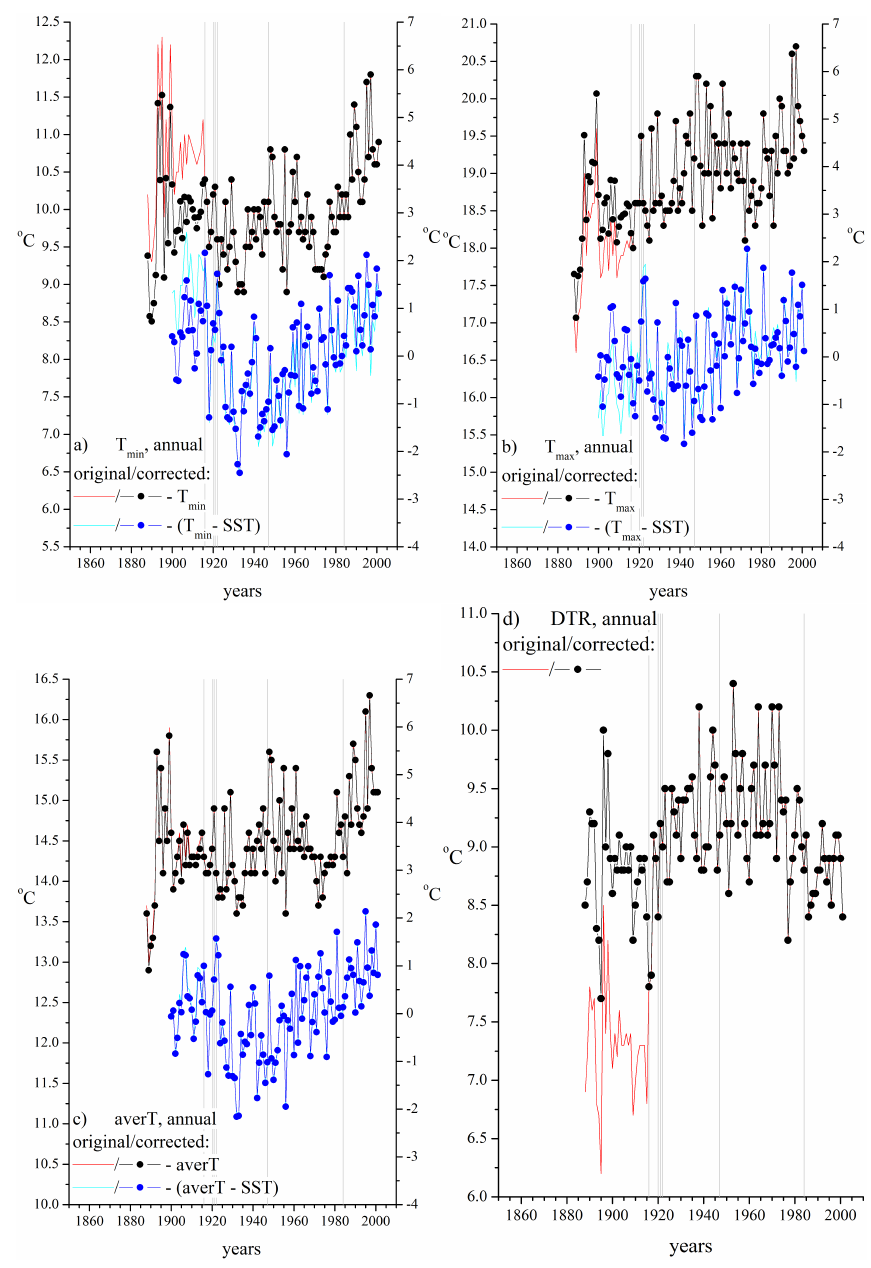
Figure 7. Porto: original and corrected annual series of T min (a) , T max (b) , T aver (c) and DTR (d) ; temperature series are shown in black and red, di ff erences between temperature and SST Porto series are shown in blue and cyan. Grey vertical bands show dates of known instruments relocation (see Table